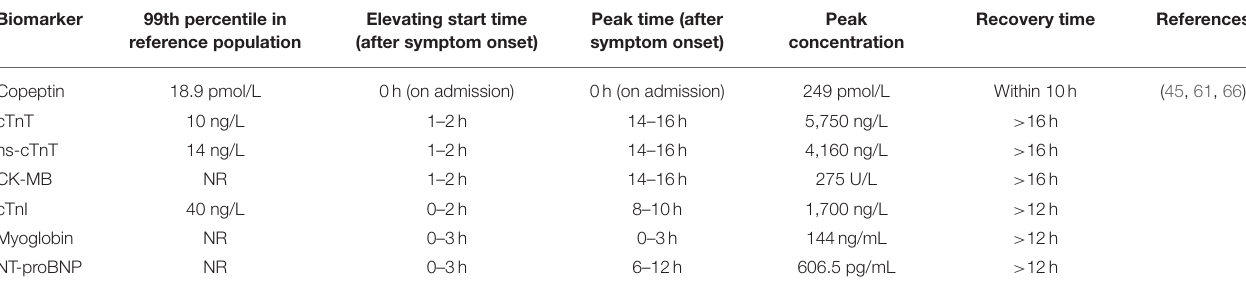
TABLE 1 | Comparison between the release patterns of copeptin and other markers after symptom onset. Biomarker